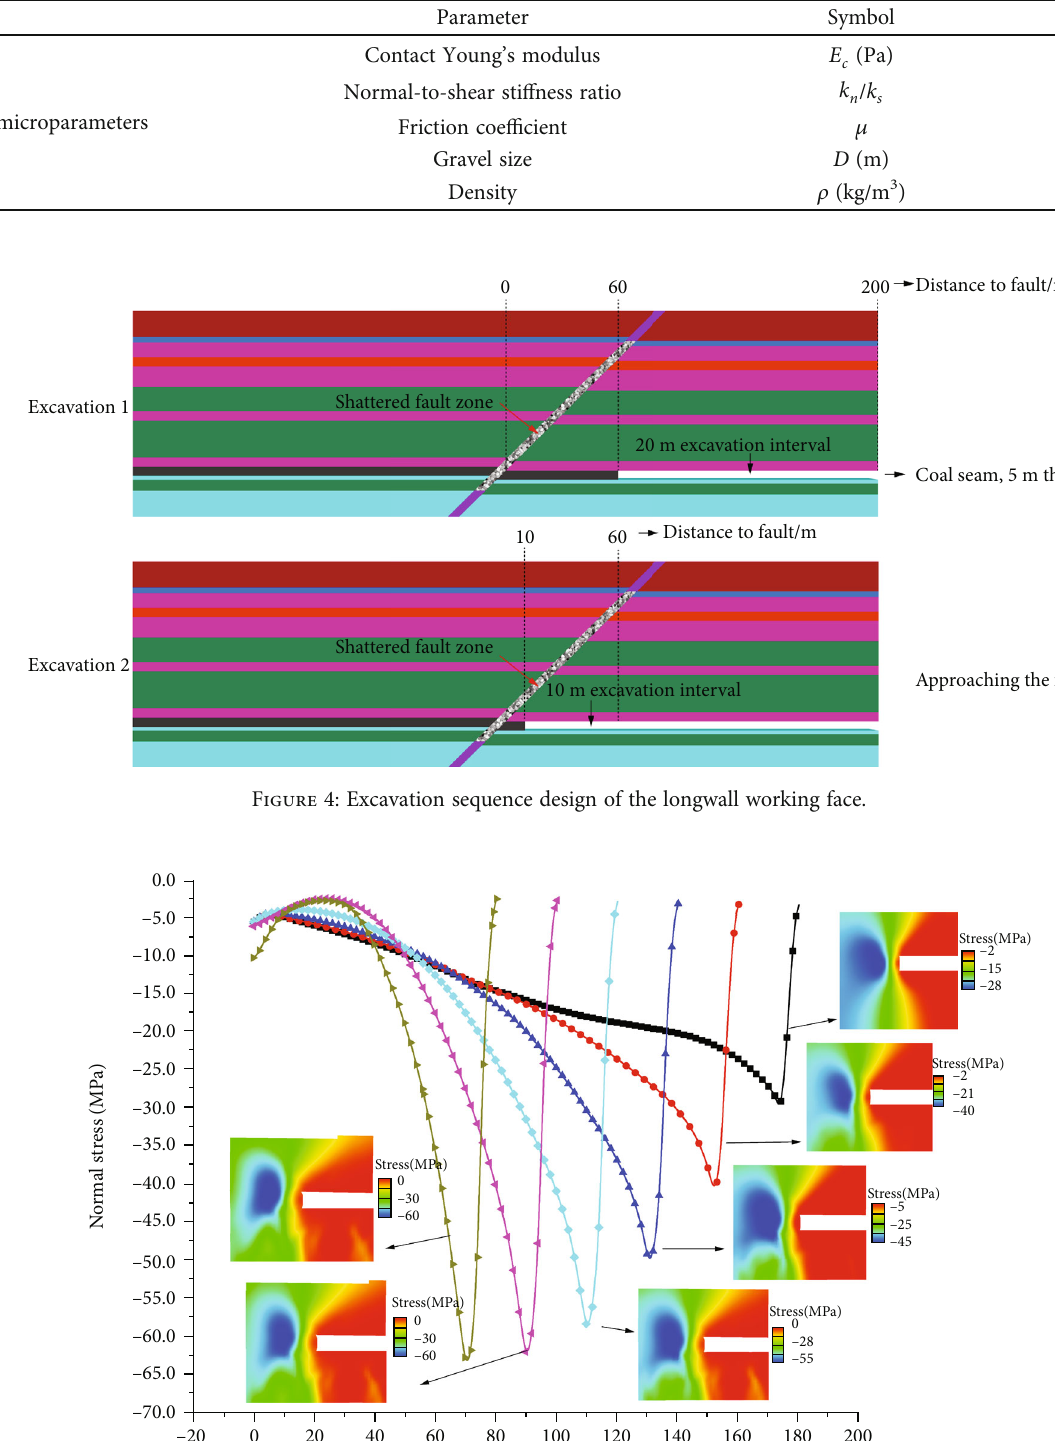
Table 2: Mechanical parameters in the DEM.